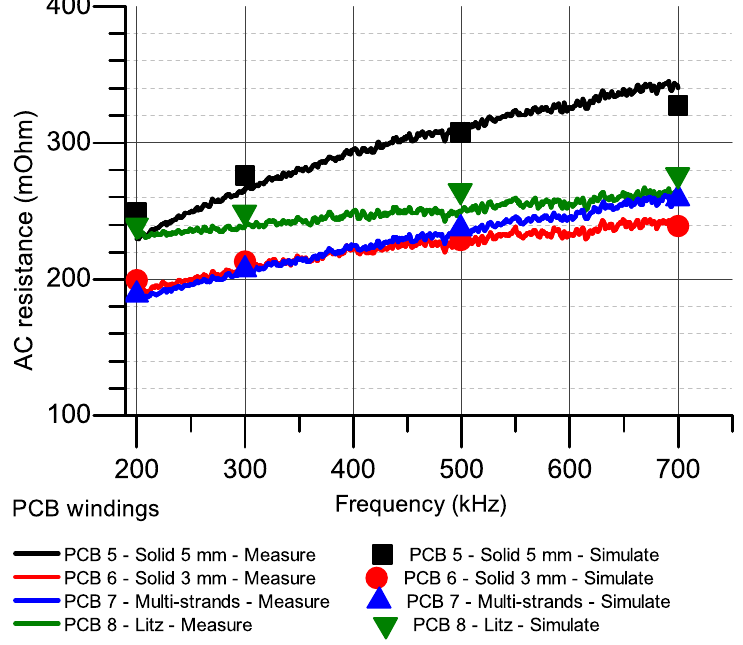
Figure 16. Measured and simulated AC resistances of 7-turn